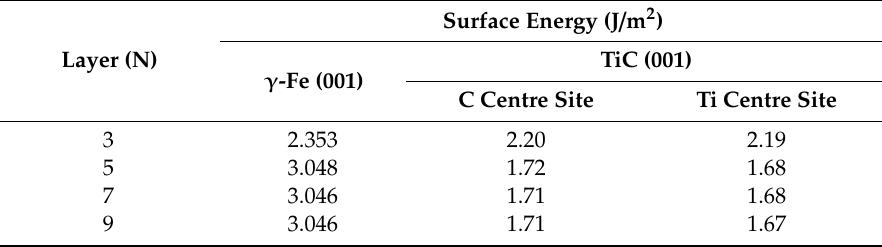
Table 3. Convergence of the surface energy with respect to slab